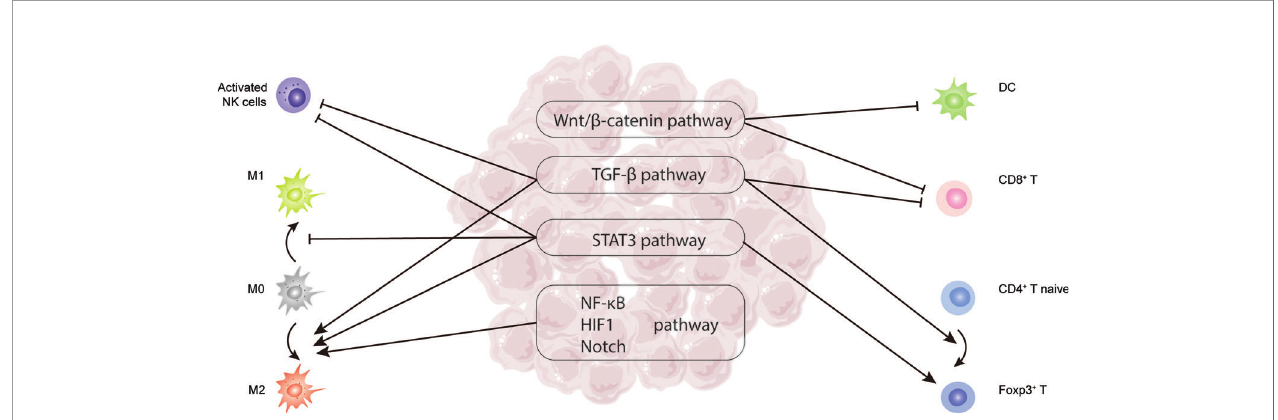
FIGURE 2 | Critical signaling pathways related to TILs in HCC, including TGF- b , STAT3, Wnt/ b -catenin, NF- k B, HIF-1, and Notch